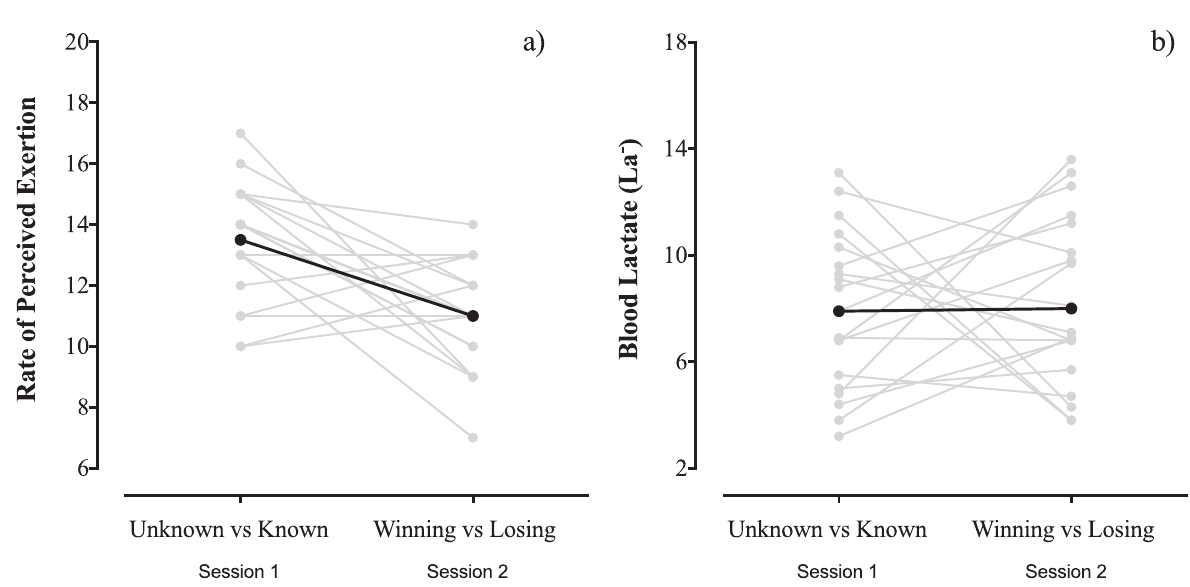
Fig 1. Characterisation of rate of perceived exertion and La - according to each testing session (Session 1: Unknowing and knowing the task duration; Session 2: Knowing the task duration and winning or losing). Note: Grey solid lines indicate the responses of individual participants; black dotted lines indicate the group mean